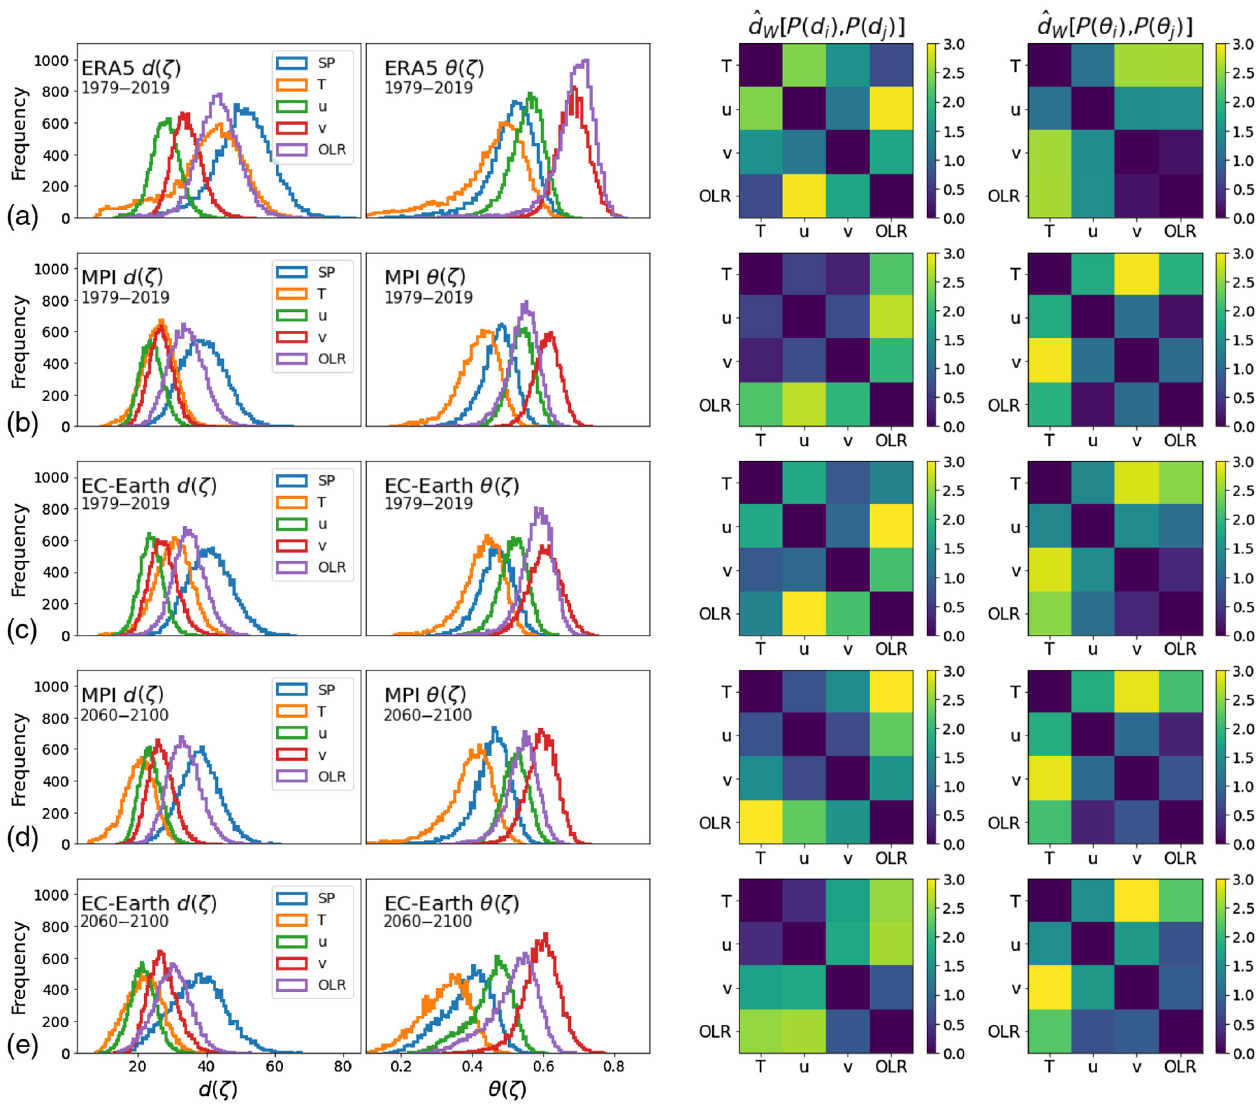
FIG. 8. (a) – (e) First and second columns: histograms of local dimension d ð ζ Þ and inverse of persistence θ ð ζ Þ for the multivariate representation (referred to as state space “ SP ” ) and univariate fields (i.e., T, u, v, and OLR). Third and fourth columns: Wasserstein distance between such histograms. For a given dataset, the variance among all distances is one. Rows (a) – (e): ERA5 reanalysis,